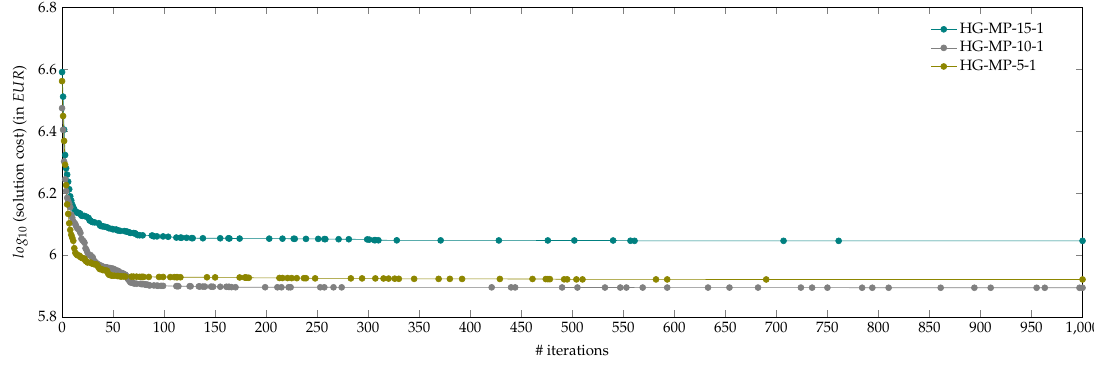
Figure 13. Long run of 1000 iterations for three